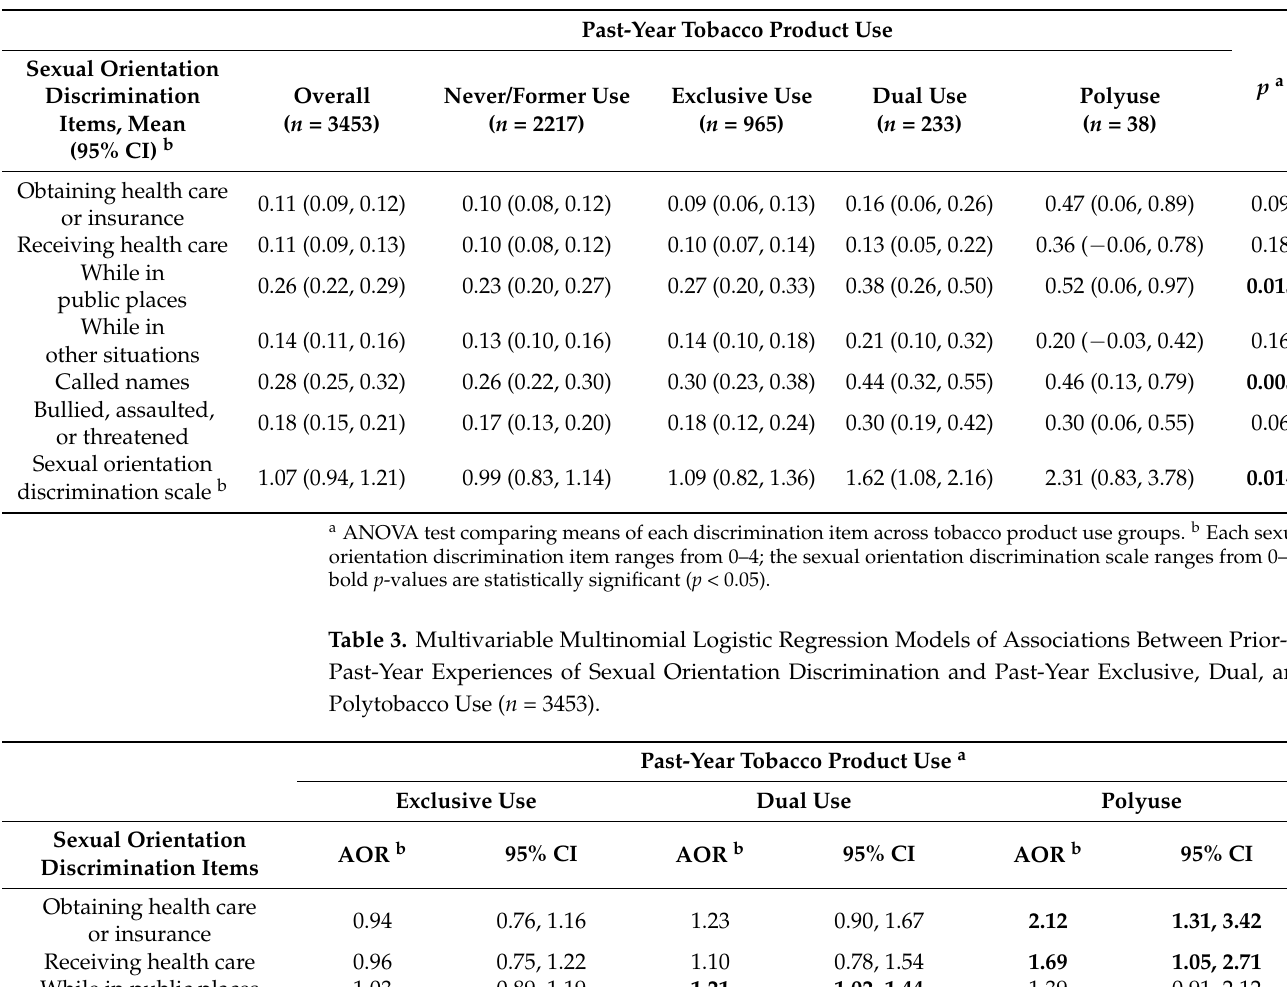
Table 2. Weighted Means of Prior-to-Past-Year Experiences of Sexual Orientation Discrimination Overall and by Past-Year Exclusive, Dual, and Polytobacco Use ( n = 3453).